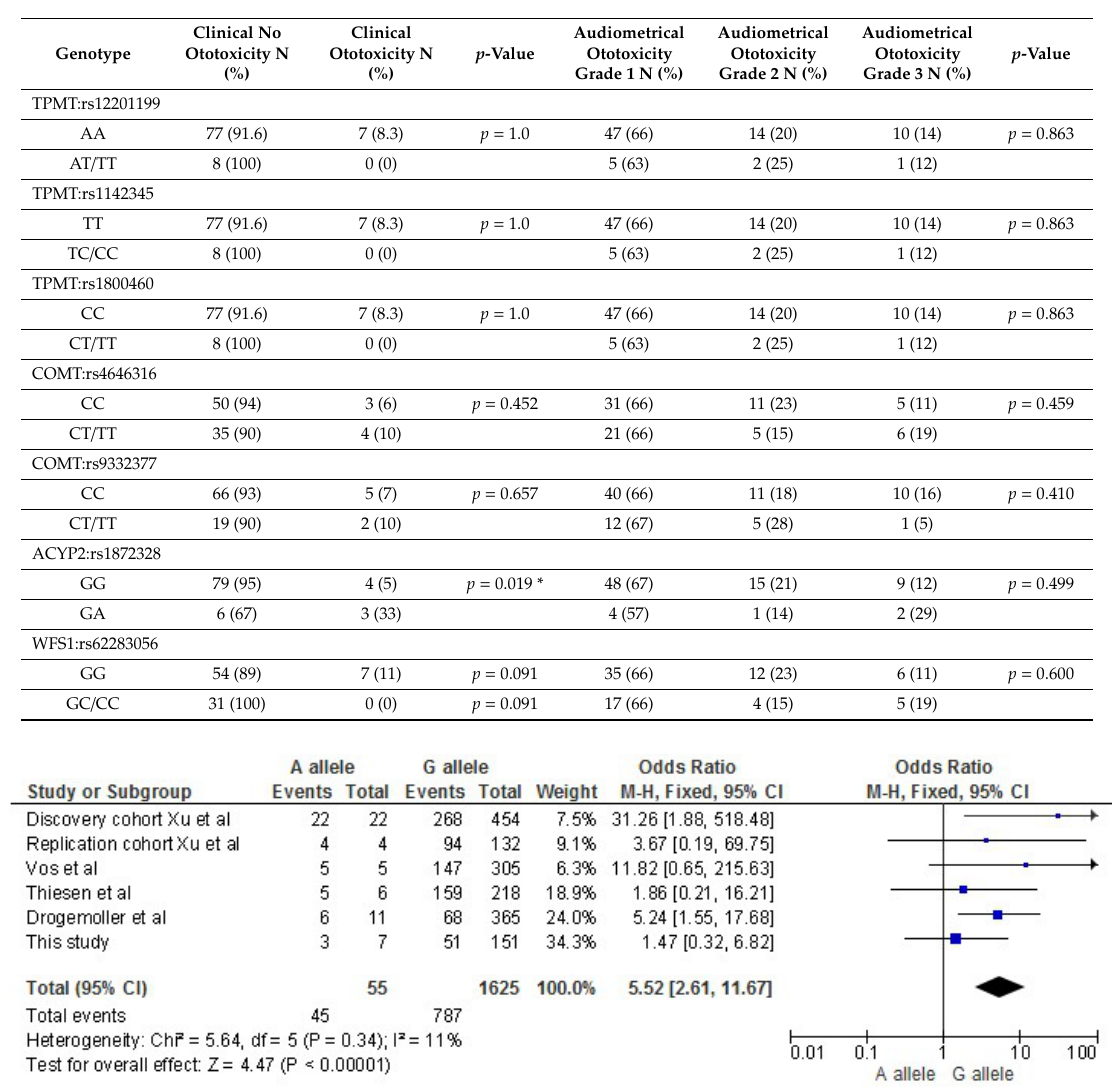
Figure 1. Forest plot of meta-analysis of ACYP2 rs1872328. Meta-analysis of published cohorts in humans and present study using a fixed-effects model. 95% CI, 95% confidence interval of odds ratio; M-H, Mantel-Haenszel method. Table 3. Significance levels for genetic variants related to ototoxicity. * = significantly different ( p < 0.05).